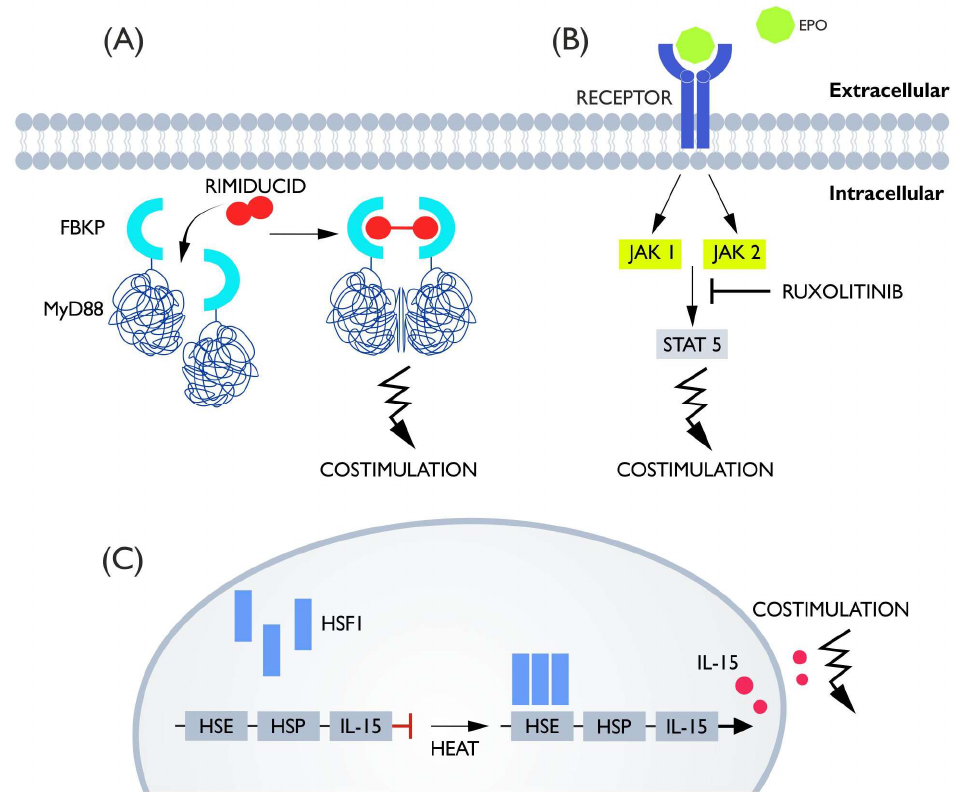
Figure 6. ( A ) MyD88 is activated by a dimerization mechanism. It is connected to FKBP. After administration of rimiducid, FKBP homodimerizes and with it, MyD88, providing an activating signal. ( B ) Erythropoietin receptor-based switch. The receptor for EPO is located on the membrane and provides an activating signal when erythropoietin is detected. This switch can be turned off by ad- ministering ruxolitinib which inhibits STAT5 phosphorylation or by restricting EPO. ( C ) HSF1 is, by default, in the free state. When heat is applied it trimerizes and binds to HSE which activates IL- 15 gene transcription.